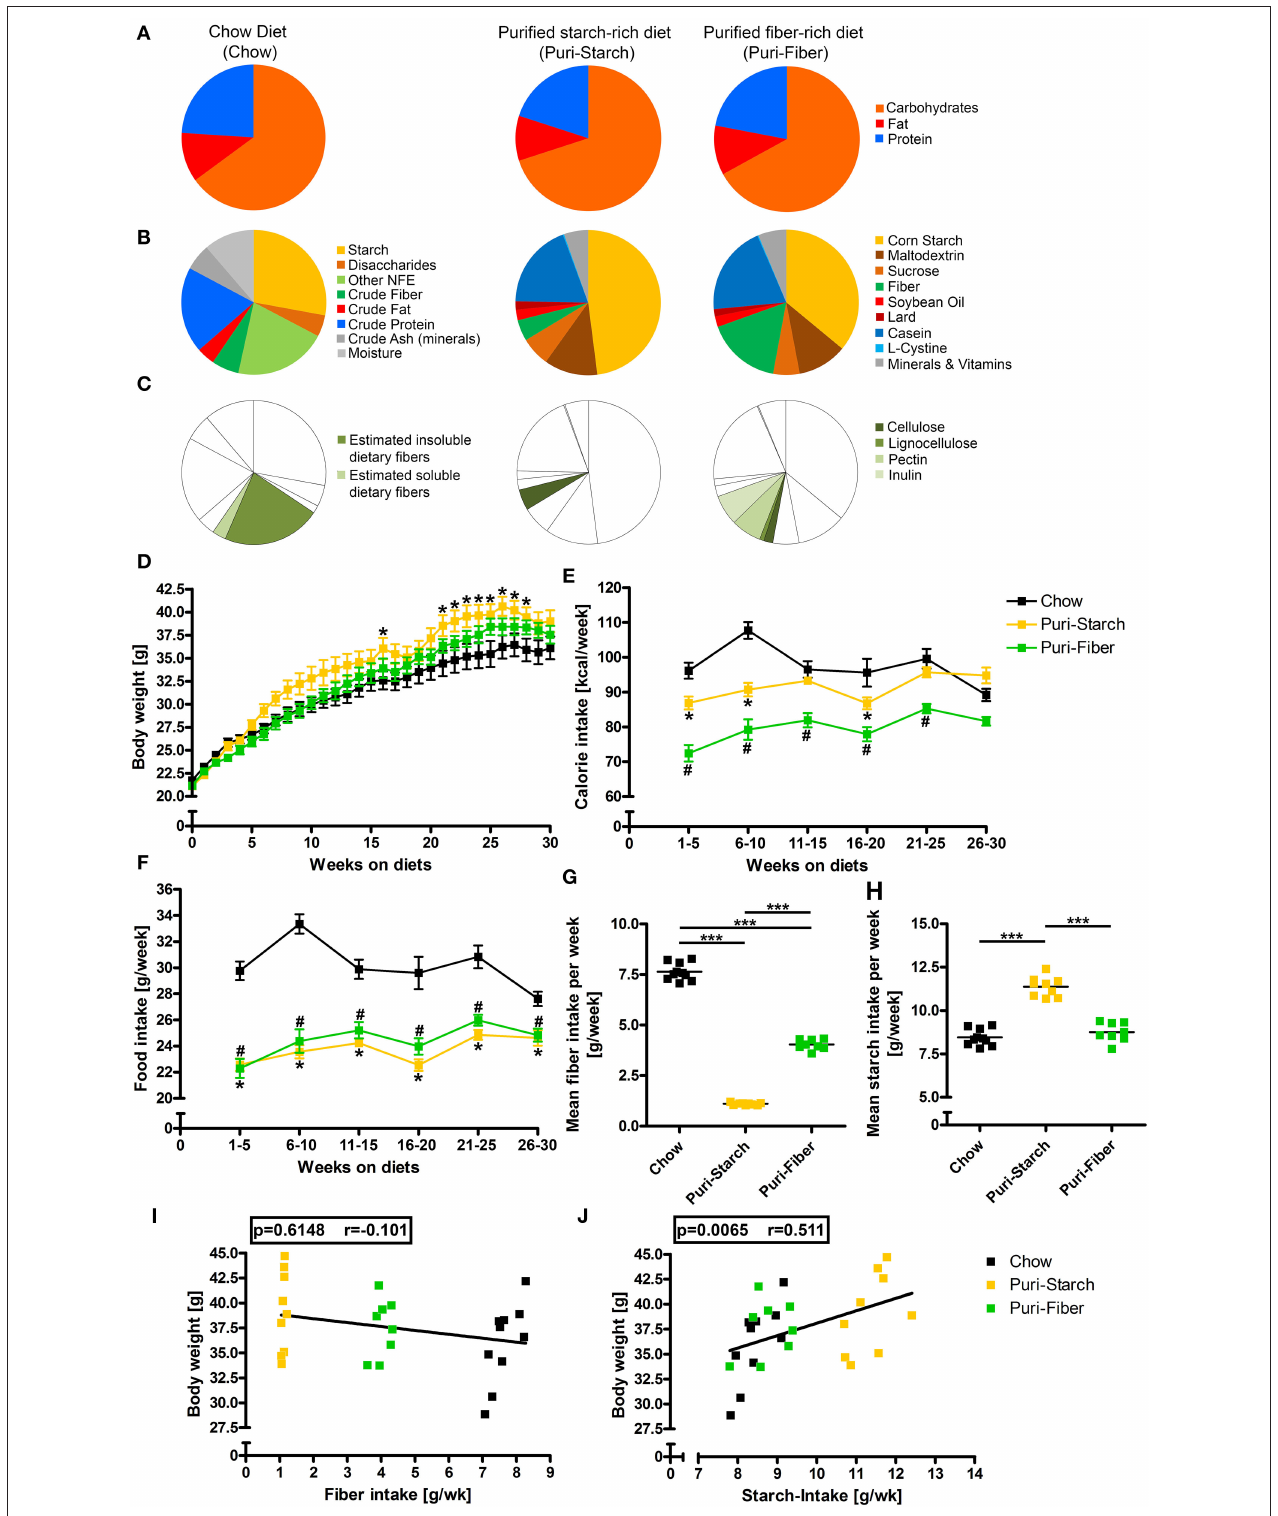
FIGURE 1 | Composition of diets and their effects on body weight, calorie consumption, and food intake. (A) Macronutrient composition of diets in kcal%. (B) Nutritional composition of diets in g%. (C) Fiber content of diets in g%. (D) Body weights in g. (E) Calorie intake in kcal/week. (F) Food intake in g/week. (G) Mean fiber intake in g/week. (H) Mean starch intake in g/week. (I) Correlation of mean fiber intake per week and body weight after 30 weeks. (J) Correlation of mean starch